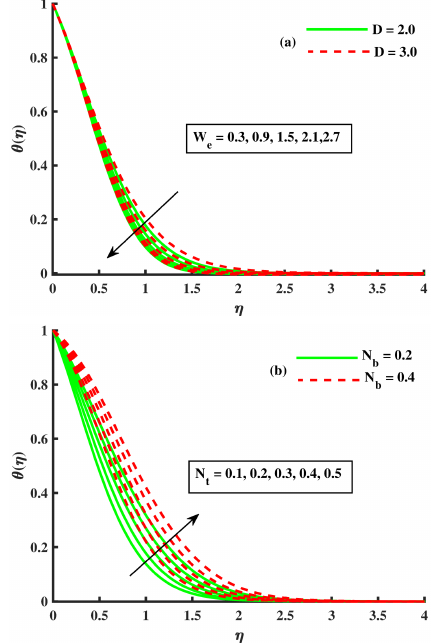
Figure 6. The effect of W e , D , N b , & N t on θ ( η )